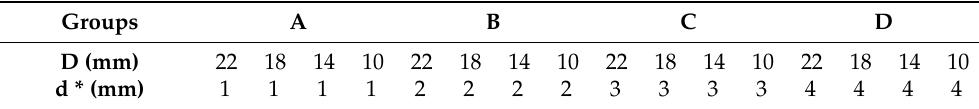
Figure 4. The test piece and the defect arrangements and dimensions. Table 2. The arrangement of depth and size of artificial